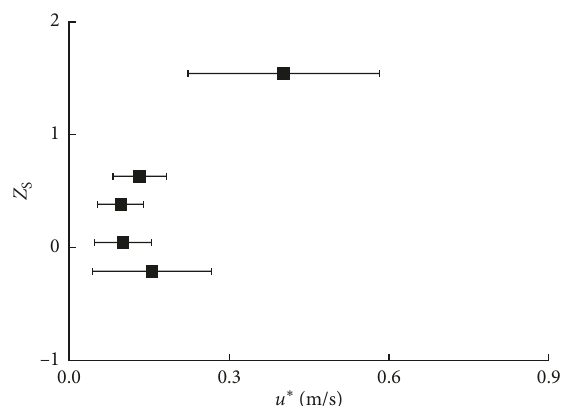
Figure 3: Vertical distribution of the half-hourly friction ve- locity averaged during campaign S2. Horizontal lines represent the standard error. Canopy height is Z S